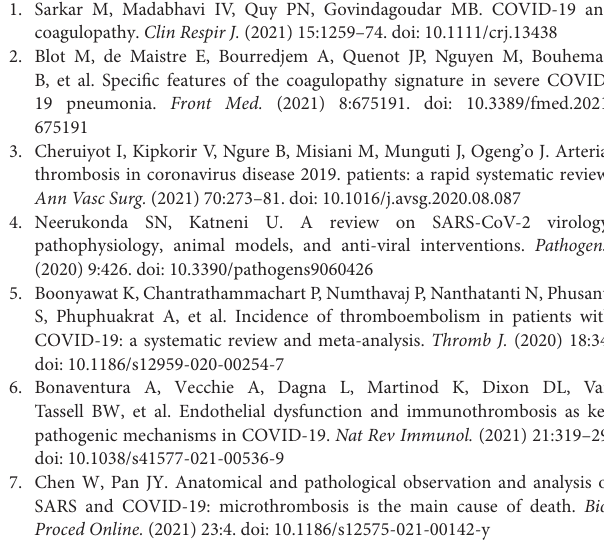
Supplementary Figure 1 | Platelet levels in COVID-19 ( − ) and COVID-19 ( + ) patients: (A) Total platelets 222(IQR, 168–293.8) ( − ), 220(IQR, 152–287) ( + ), p